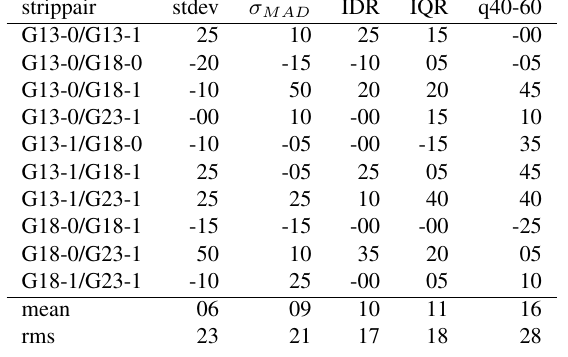
Table 2. Nominal-actual comparison of all strip pair combinations and all tested statistics in [cm] for section